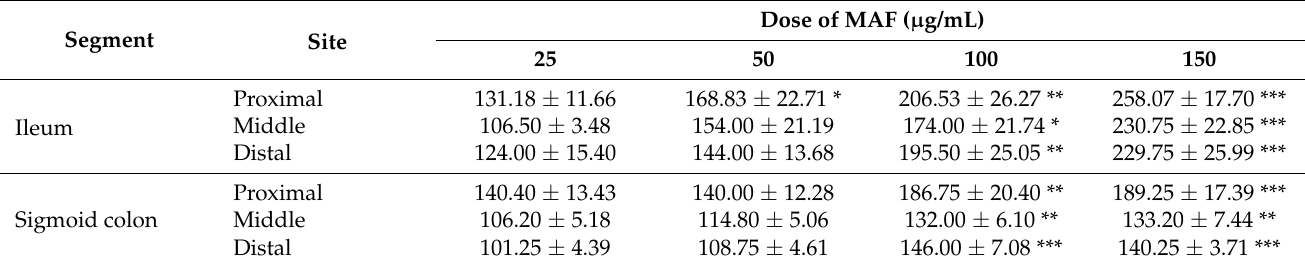
Table 3. Relative AUC values (% of control) for MMCs after treatment with each dose of MAF in human ileal and colonic segments in